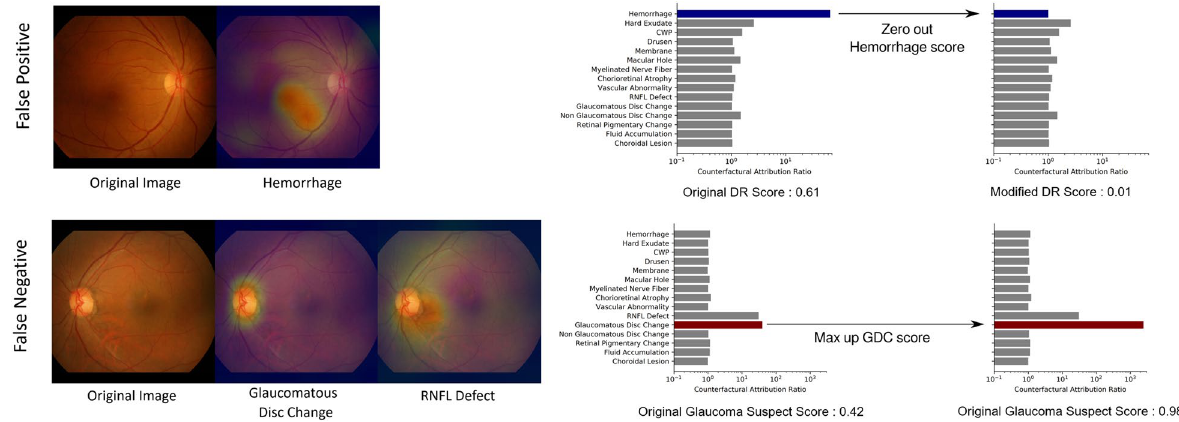
Figure 4. Interactive diagnosis using counterfactual attribution ratio and the attribution maps of relevant findings. (top) A false-positive diagnosis of diabetic retinopathy can be corrected by suppressing the overestimated attribution of hemorrhage. (bottom) A false-negative diagnosis of glaucoma can be corrected by increasing the underestimated attribution of glaucomatous disc